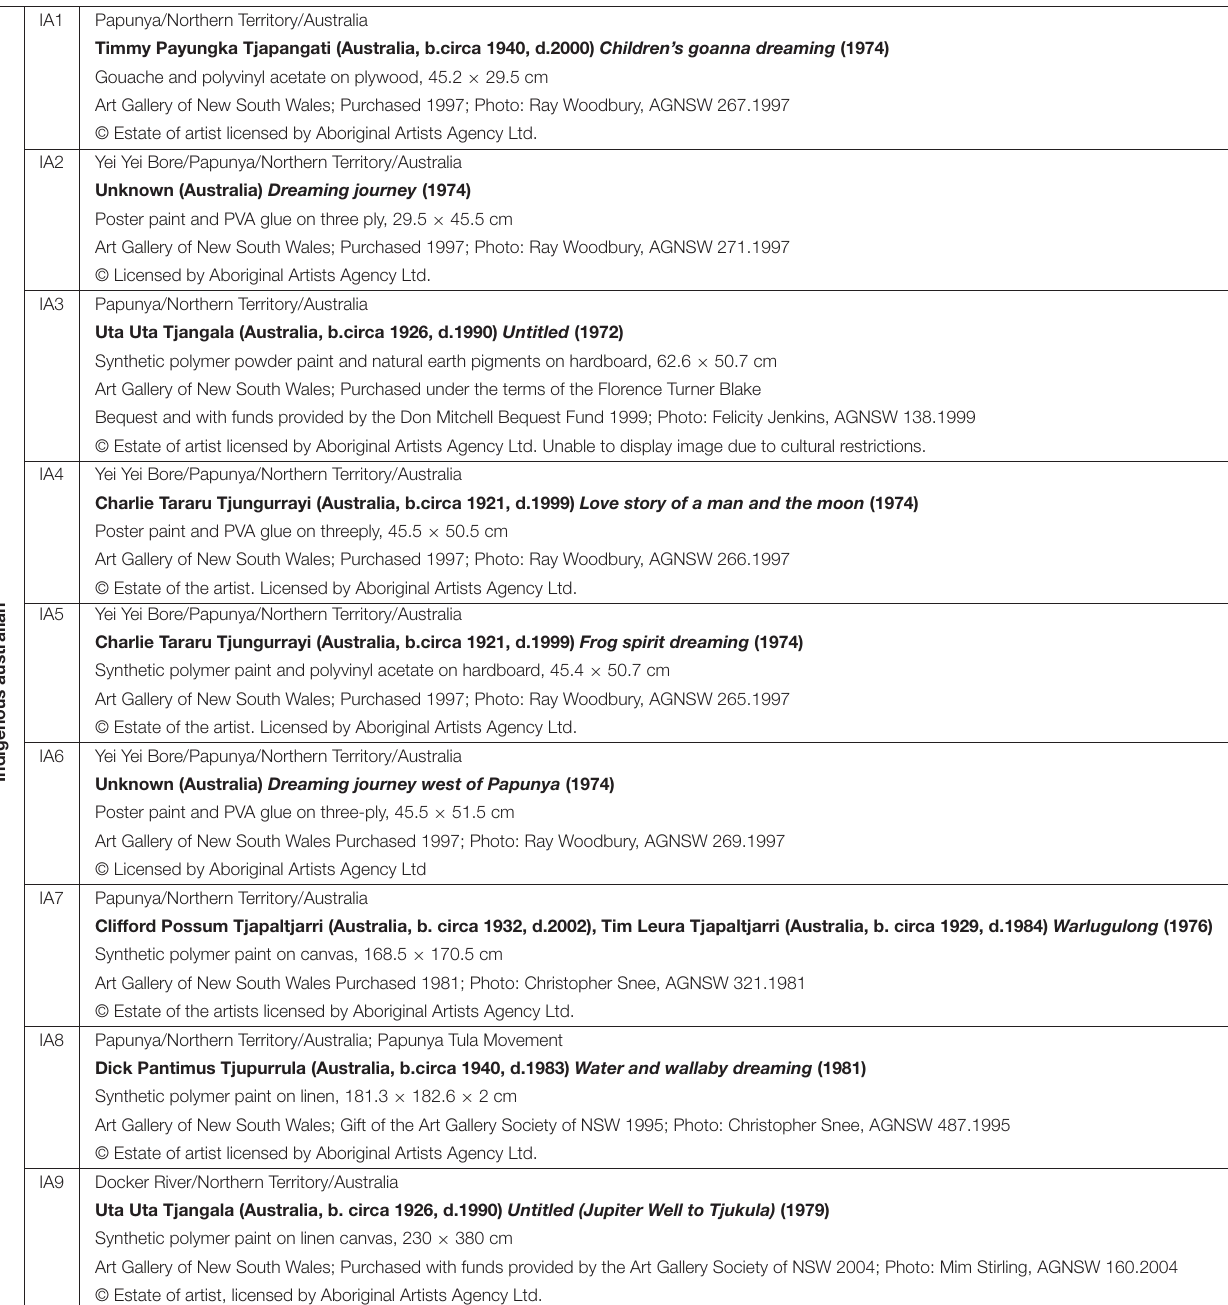
TABLE 2 | Indigenous